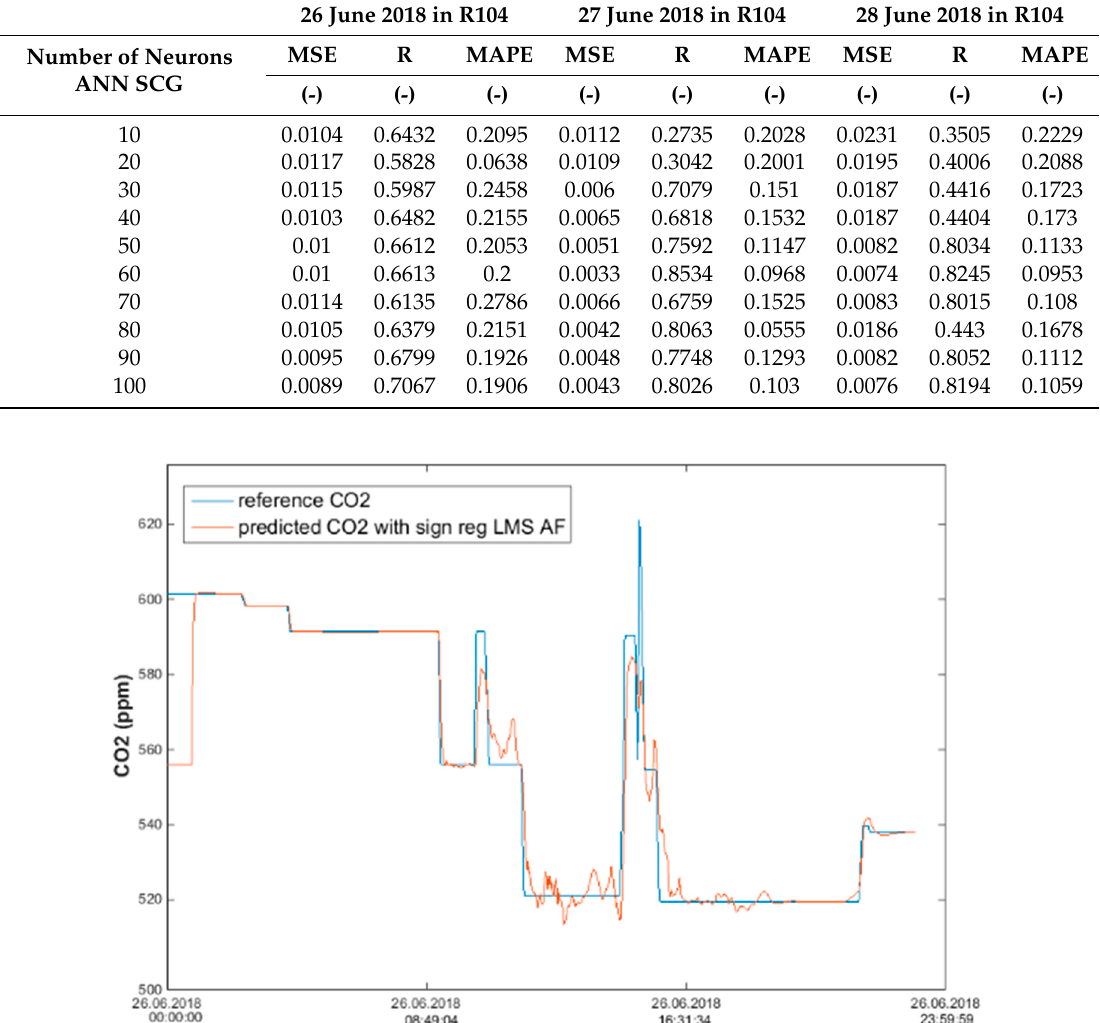
Figure 27. Bland–Altman for the reference and predicted CO 2 waveforms (SRLMS AF) from 26 June 2018 in R203 with an ANN with 60 neurons and SCG method trained with data from 25 June 2018 in R203. Table 6. Learned ANN SCG from 25 June 2018 in R203 (with T in, rH in and an FBG sensor for PPM) and prediction with cross-validation for 26 June 2018 in R204 (with T in, rH in and an FBG sensor for PPM), 27 June 2018 in R204 (with T in, rH in and an FBG sensor for PPM), 28 June 2018 in R204 (with T in, rH in and an FBG sensor for PPM). 26 June 2018 in R204